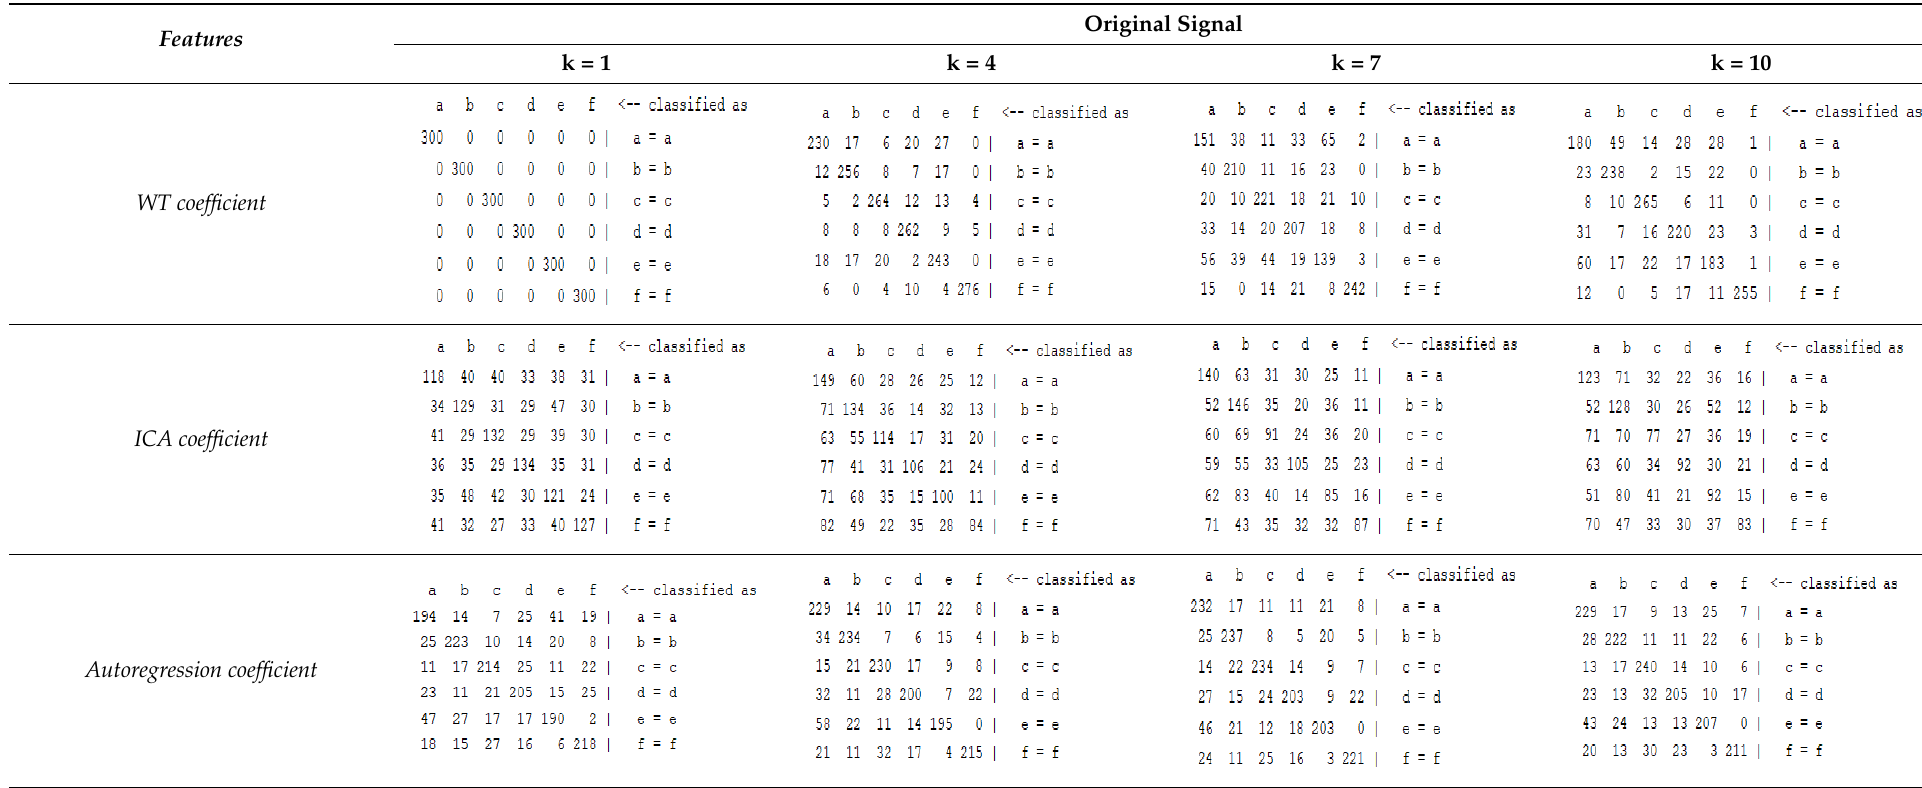
Table 3. The confusion matrix of the KNN method—raw signal part.